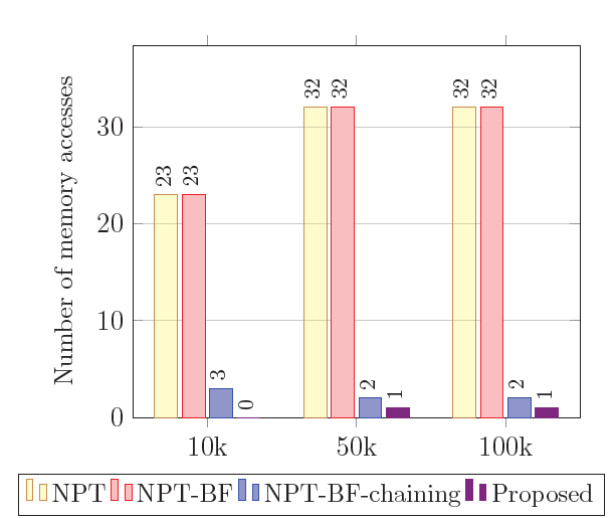
Figure 5. Worst-case number of off-chip memory accesses.